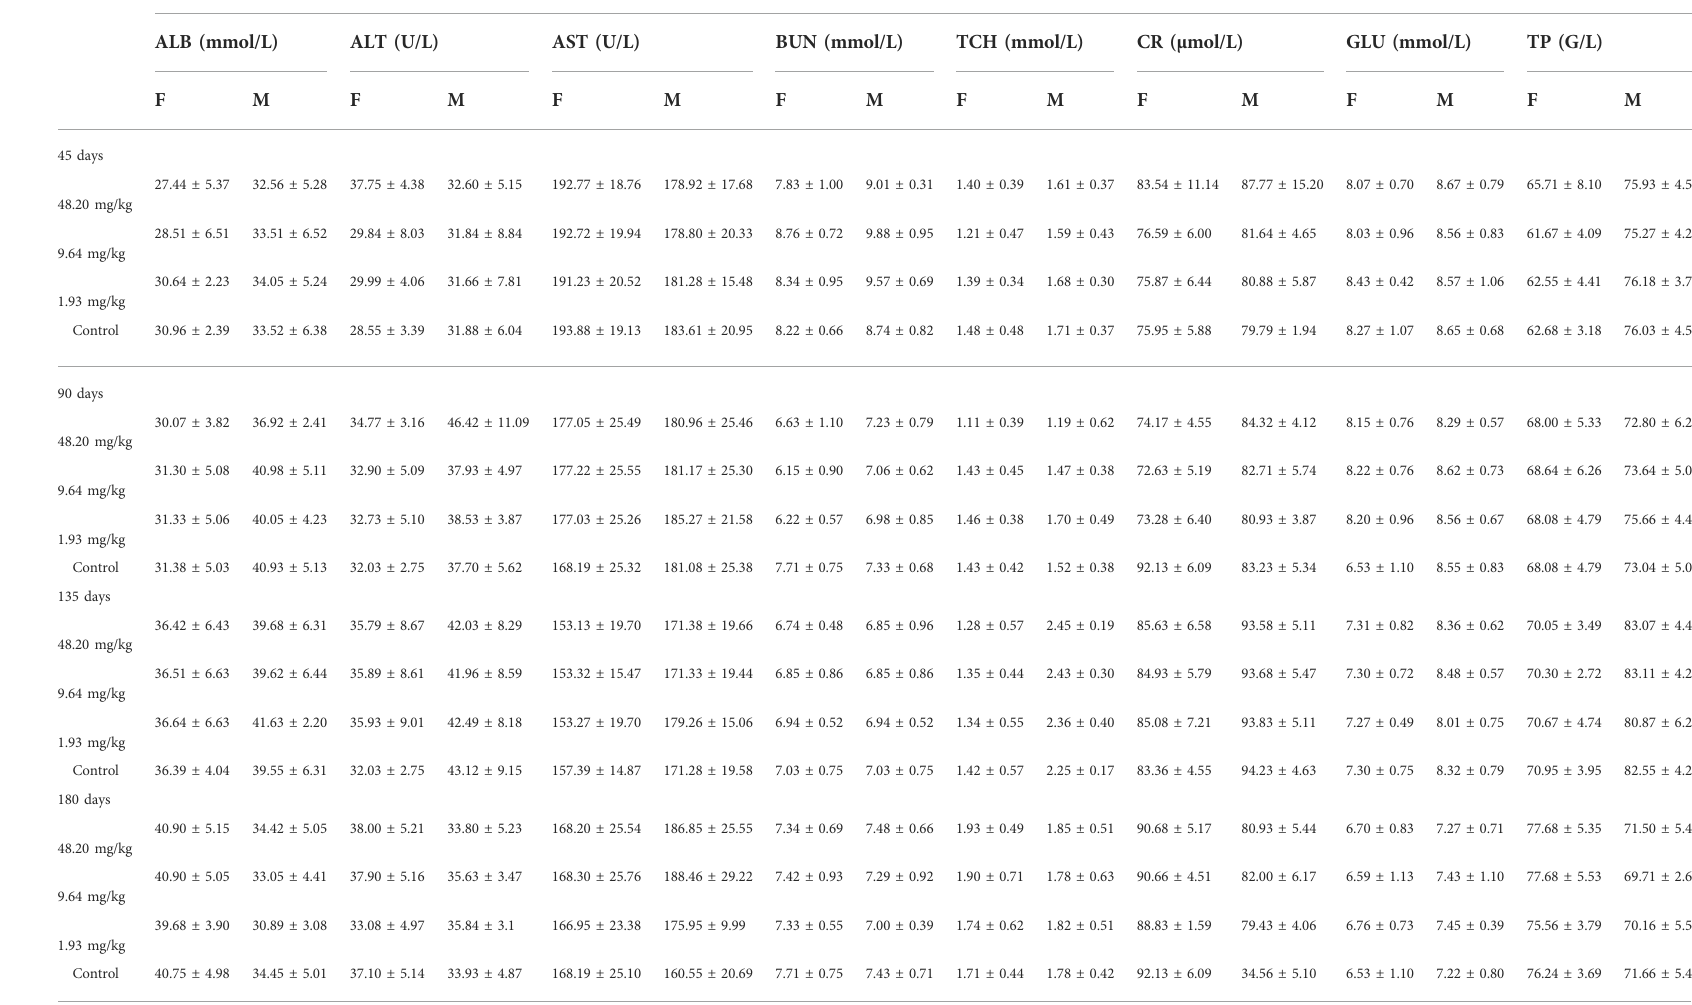
TABLE 8 Effect of MPTA on clinical chemistry indices in